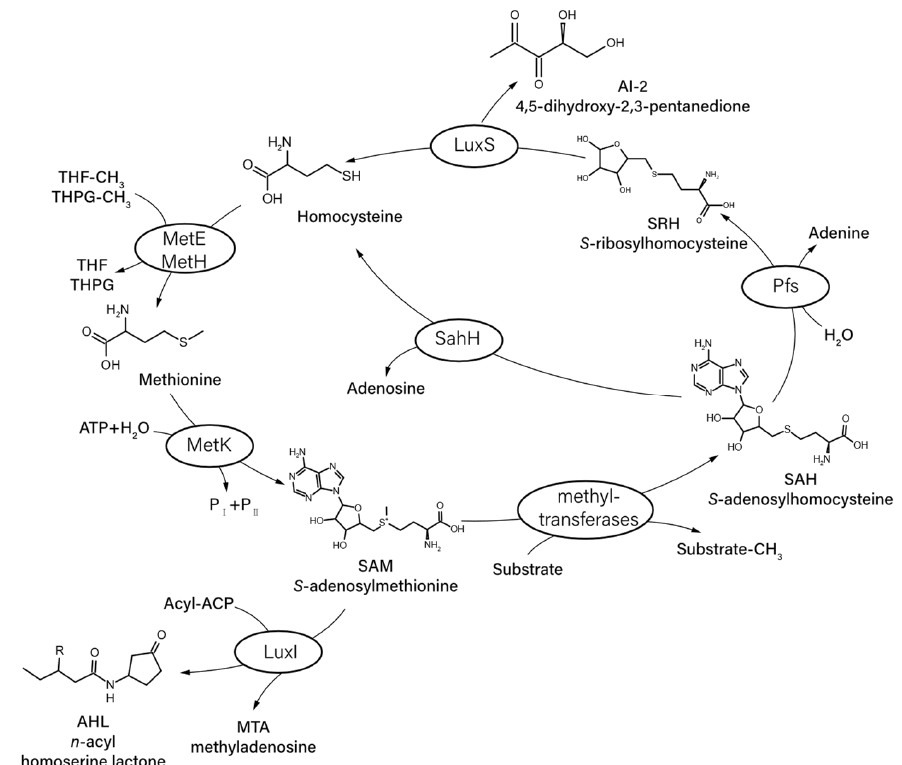
Figure 2. Diagram illustrating the AI-2 and AHLs biosynthetic pathway (modified from [29]). SAM is transformed into SRH via a series of reactions, and SRH is subsequently converted to DPD, the linear form of AI-2. SAM also serves as substrate with Acyl-ACP for the synthesis of AHLs.